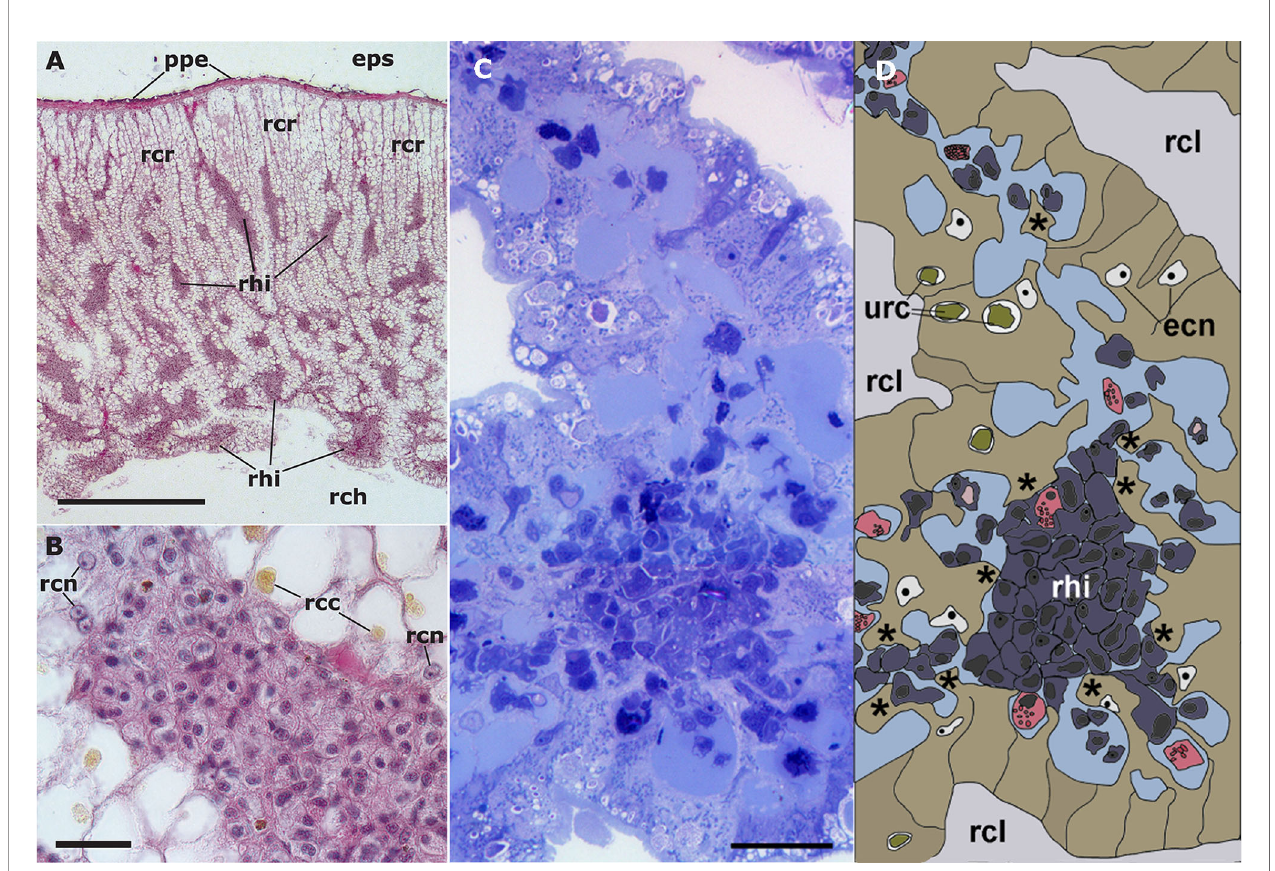
FIGURE 5 | Constitutive hemocyte islets (panels (A, B) , paraf fi n and hematoxylin-eosin; panel (C) , Spurr resin and toluidine blue). (A) Section of the dorsal renal epithelium, perpendicular to the outer surface of the organ. The pigmented outer mantle epithelium separates the kidney from the extrapallial space. Renal hemocyte islets are seen as elongated basophilic masses between the cortical renal crypts, while they appear transversally sectioned in the region overlying the renal chamber. (B) Section of a hemocyte islet in the space between two epithelial crypts, at higher magni fi cation. (C) Section through a medium-sized hemocyte islet which is retained in place by basal extensions of the renal epithelial cells. (D) Diagram of the same section shown in (C) , highlighting a hemocyte islet, together with some smaller aggregations; the entire set is retained in place by cytoplasmic extensions (asterisks) of renal epithelial cells (light brown); the space for the fl owing blood plasma is shown in pale blue. Hyalinocytes are shown in dark blue while granulocytes are shown in pink. Scale bar represents 20 µm. ECN, epithelial cell nuclei; EPS, extrapallial space; PPE, pigmented pallial epithelium; RCC, renal cell concretion; RCH, renal chamber; RCL, renal crypt lumen; RCN, renal cell nucleus; RHI, renal hemocyte islet; URC, urinary concretions. From (29,